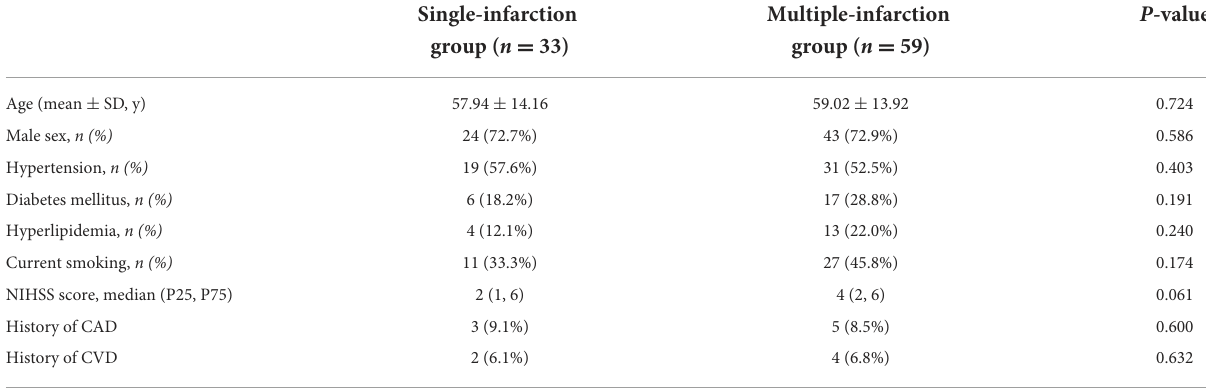
TABLE 1 Clinical characteristics of patients with single infarction and multiple infarction.